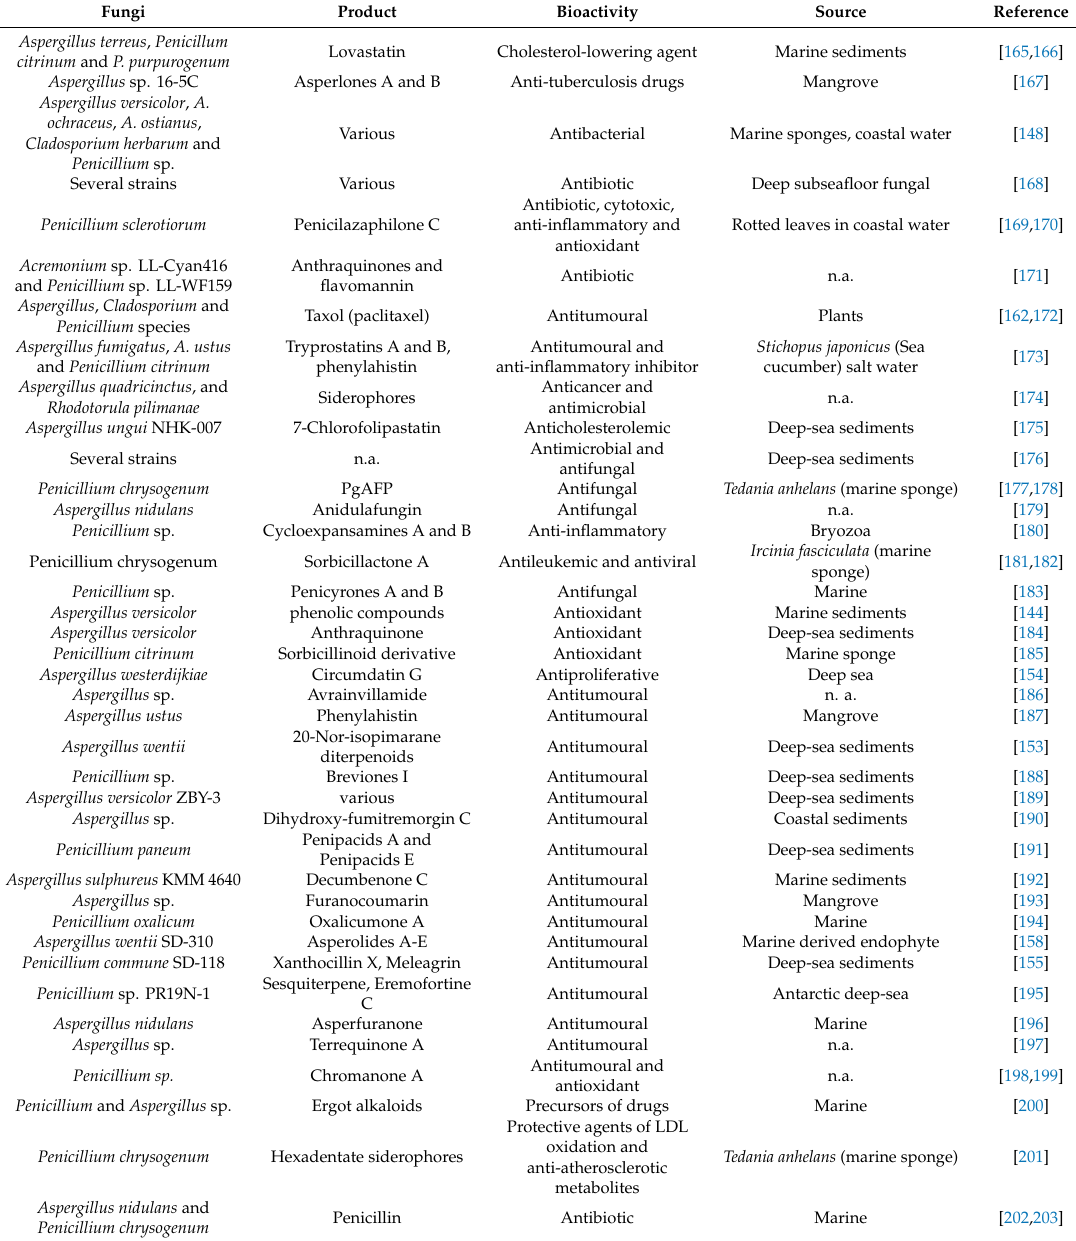
Table 3. Examples of bioactive molecules for therapeutic use isolated from marine fungi belonging to the genera found in